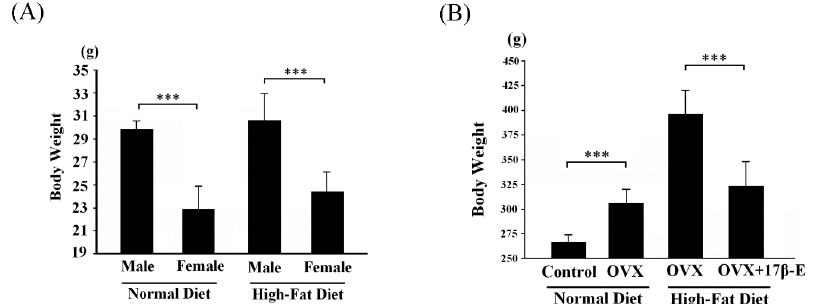
Figure 1. The body weight control effects of estrogen in C57B mice and Sprague-Dawley (SD) rats. ( A ) The body weight of male/female C57B mice fed with normal or high-fat diet for 30 days ( n = 6 in each group). ( B ) The body weight of female SD rats, ovariectomized (OVX)-female SD rats and high-fat diet-fed OVX-female SD rats with or without 17 β -E treatment (12 μ g/kg/day) for 30 days. (*** = p < 0.001 compared with the indicated group.)